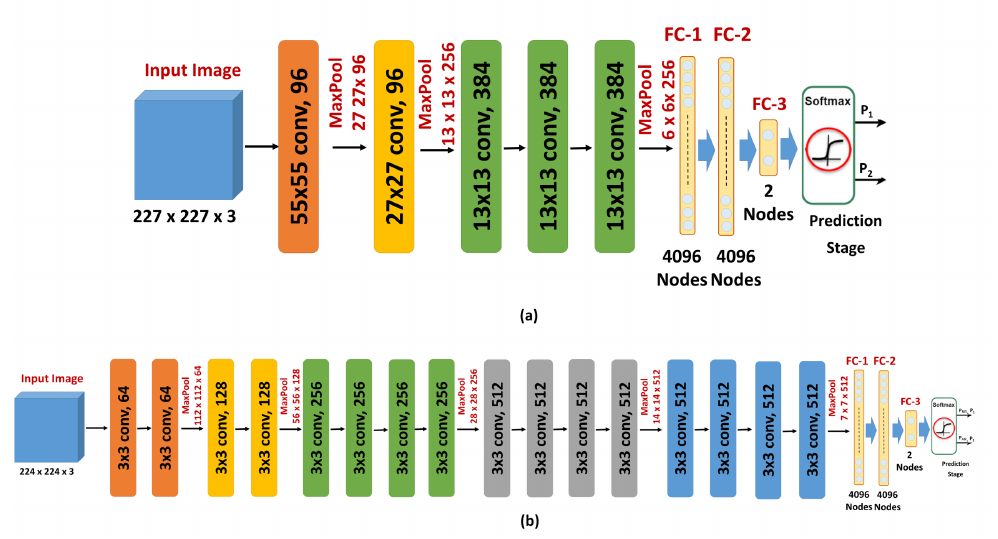
Figure 4. Illustration of the two different CNNs used in this study, ( a ) ALexNet, and ( b ) VGGNet. The introduction and success of AlexNet have revolutionized the use of CNNs for multiple classification tasks. AlexNet is a CNN that contains five convolutional layers and three FC layers (Figure 4a). The network depth has a remarkable influence on its accuracy as the accuracy of AlexNet drops by 2% in the case of removing any of the five convolution layers. Rectified linear units (ReLUs) [41] are employed as activation functions by AlexNet. There are two main advantages of using ReLUs. First, ReLUs are saturation-free even in case of unnormalized inputs. Second, the training time of CNNs with ReLUs is shorter